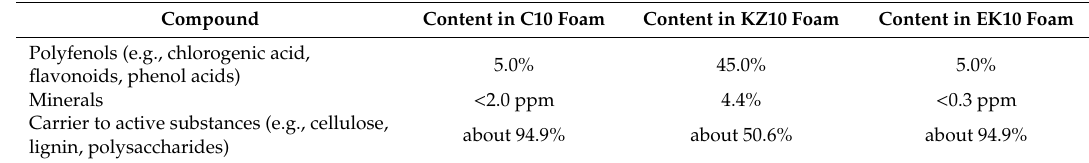
Table 1. Extracts composition: C—cinnamon, KZ—green co ff ee, EK—cocoa.